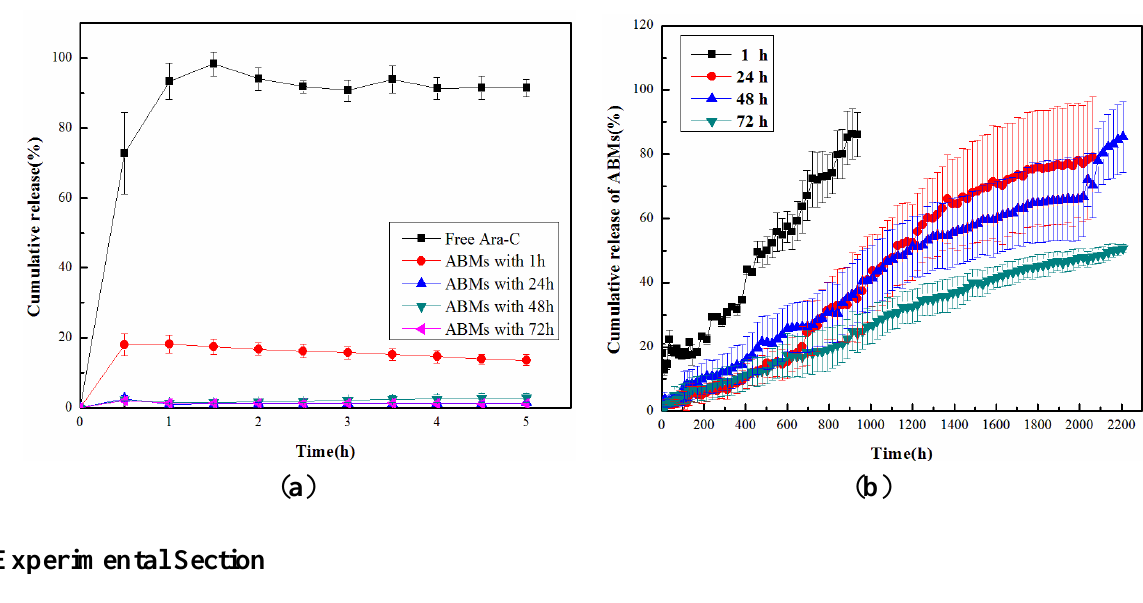
Figure 4. Cumulative release of ( a ) free Ara-C and ( b )